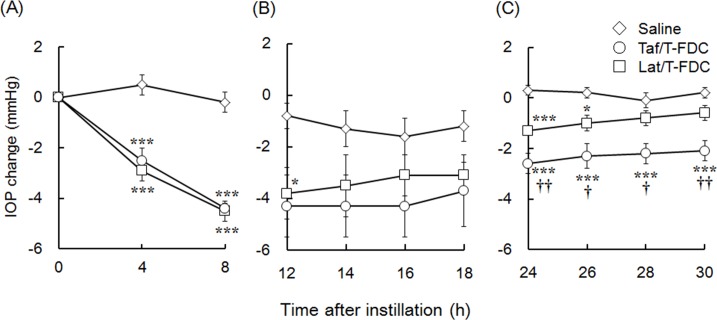
Effects of topical instillation of Taf/T-FDC and Lat/T-FDC on intraocular pressure (IOP) in ocular normotensive monkeys.Saline (20 μL), Taf/T-FDC (20 μL), or Lat/T-FDC (20 μL) were topically instilled to right eyes, while left eyes remained untreated. IOP was measured using a pneumatic tonometer. Changes in IOP were calculated as the difference from pre-instillation IOP values at the 0 h time point. (A, B) Data represent the mean IOP change ± SEM of 5–6 eyes (saline-treated group and Taf/T-FDC-treated group, n = 6; Lat/T-FDC treated group, n = 5). (C) Data represent the mean change in IOP ± SEM of 9 eyes. * P < 0.05, *** P < 0.001 vs Saline, †P < 0.05, ††P < 0.01 vs Lat/T-FDC according to Tukey’s multiple comparison test.